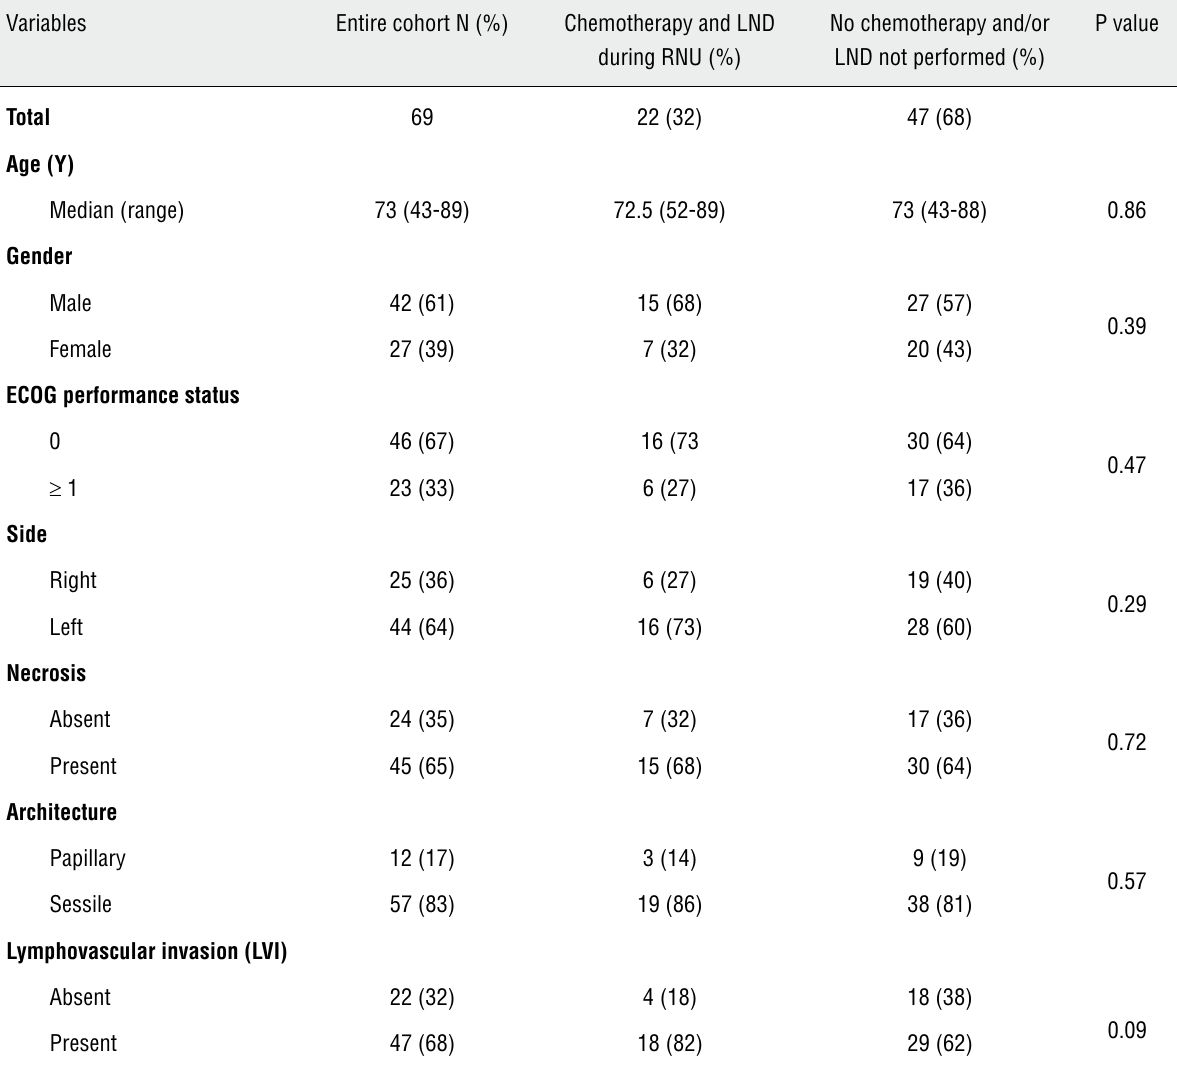
Table 1 - Clinico-pathological characteristics of T4 uTuC cases at RNu. Variables Entire cohort N (%) Chemotherapy and